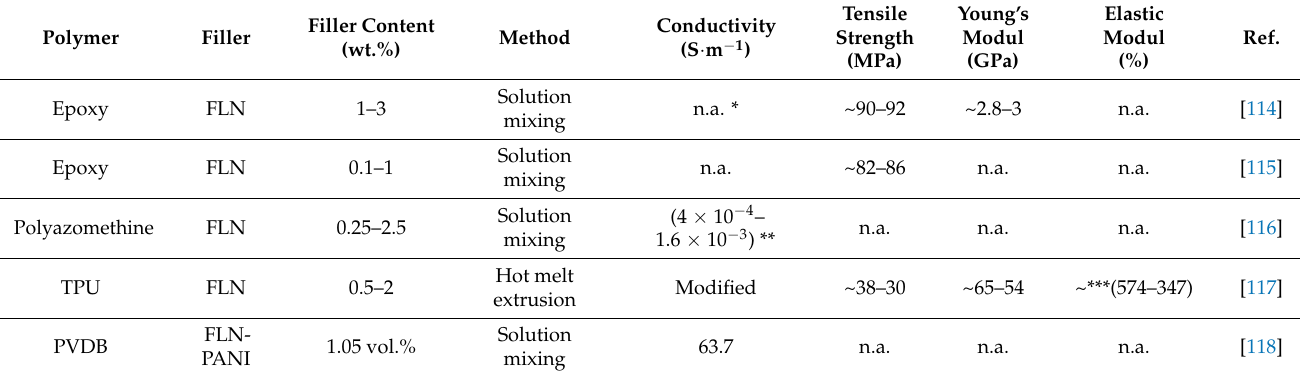
Table 6. Electrical conductivity and mechanical properties of FLN/polymer nanocomposites. Filler Content Polymer Filler